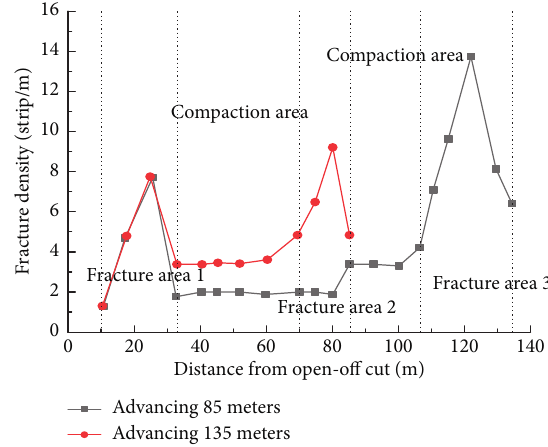
Figure 6: Distribution of fracture density of overlying strata from open-off cut to mining face.